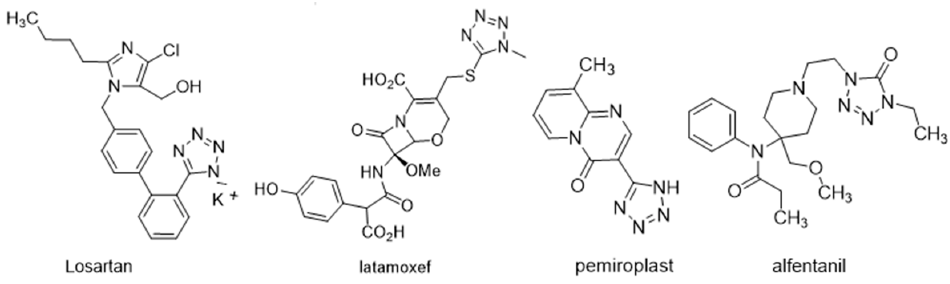
Figure 1. Examples of active ingredients of tetrazolyl-containing drugs. The manifestations of such different biological activity are associated with the unique features of the high-nitrogen tetrazole ring. It is known that the tetrazole cycle is a bioiso- steric analog of the cis-amide and carboxyl groups, which ensures the high metabolic sta- bility of tetrazole derivatives [3]. An important property of tetrazoles is the participation of “pyrrole-like” (NH group) and “pyridine-like” nitrogen atoms of the ring of types in the formation of multiple hydrogen bonds with the molecular structures of active sites of biological targets [2,4].